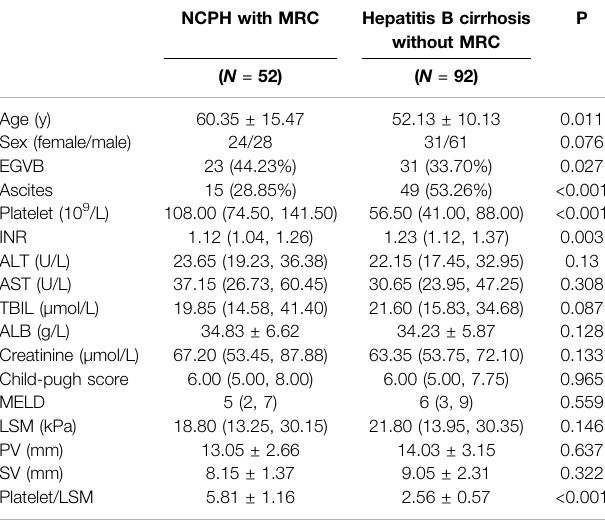
TABLE 1 | Comparison of clinical characteristics between NCPH patients with MRC and Hepatitis B cirrhosis without